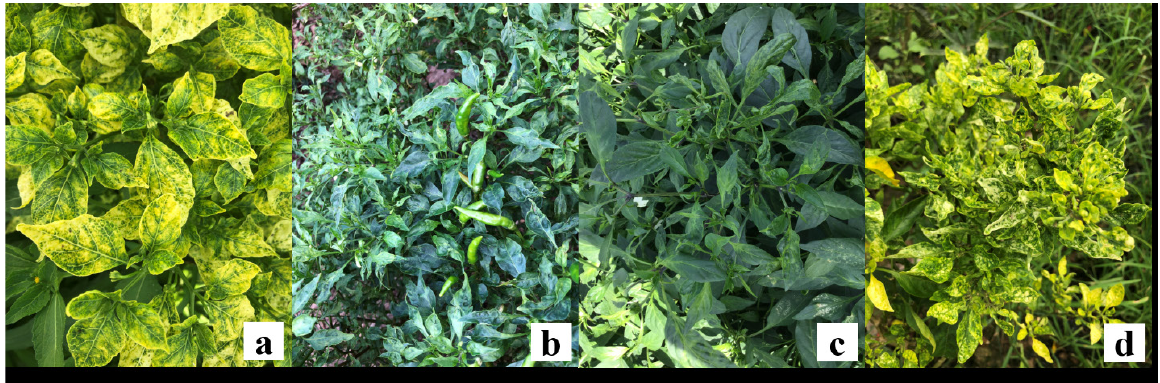
Figure 5: Diseased symptoms of the peppers possibly caused by mixed infections of the viruses. (a) yellow leaf curl and mosaic induced by ChiVMV and Begomovirus; (b) veinal mottle by CMV and ChiVMV; (c) chlorotic flecks and necrosis by CMV, ChiVMV and TNRV; (d) yellow mosaic, leaf curling and stunted by CMV, ChiVMV, TNRV and